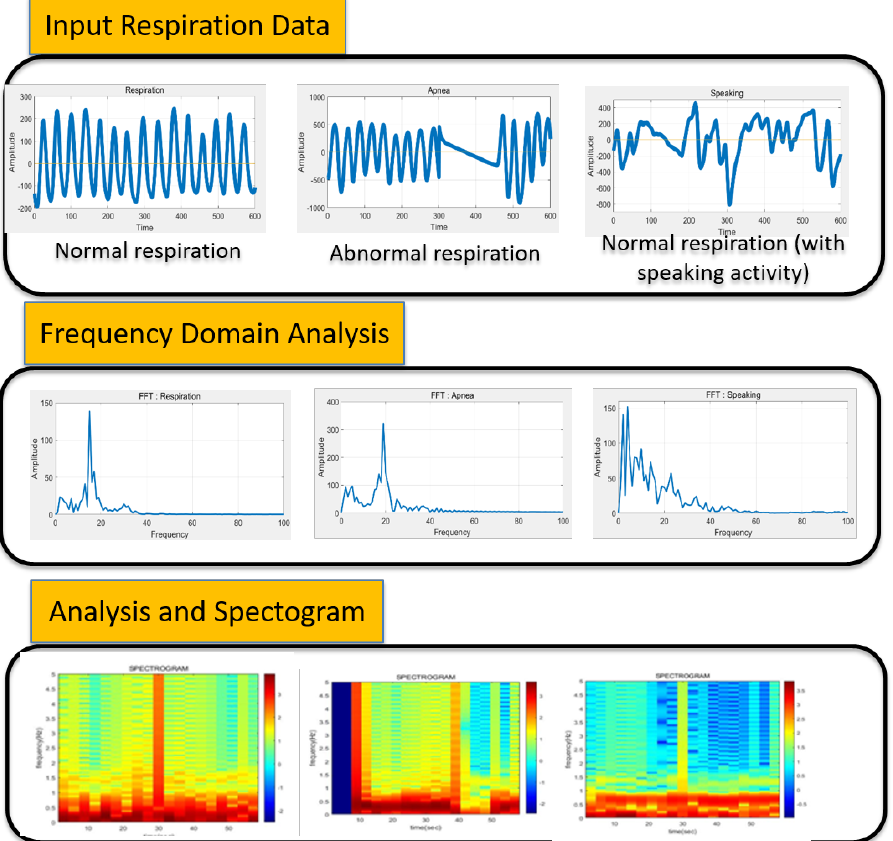
Figure 6. Frequency analysis of signals in the respiratory